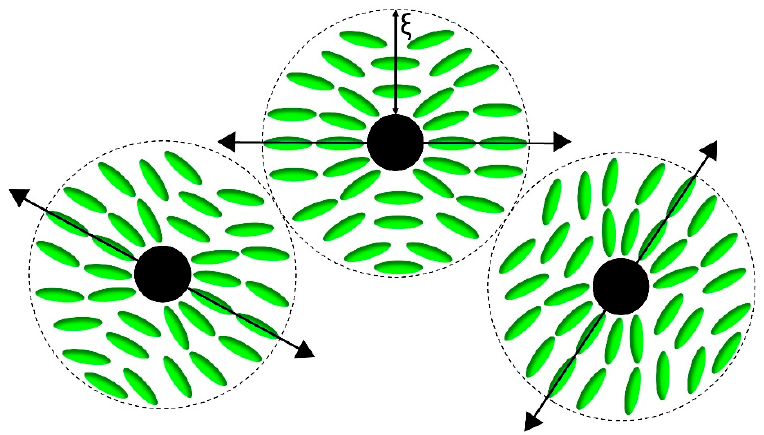
Figure 1. Schematic presentation of paranematic clusters embedded in the isotropic fluid. Double arrows indicate average orientation within each cluster .